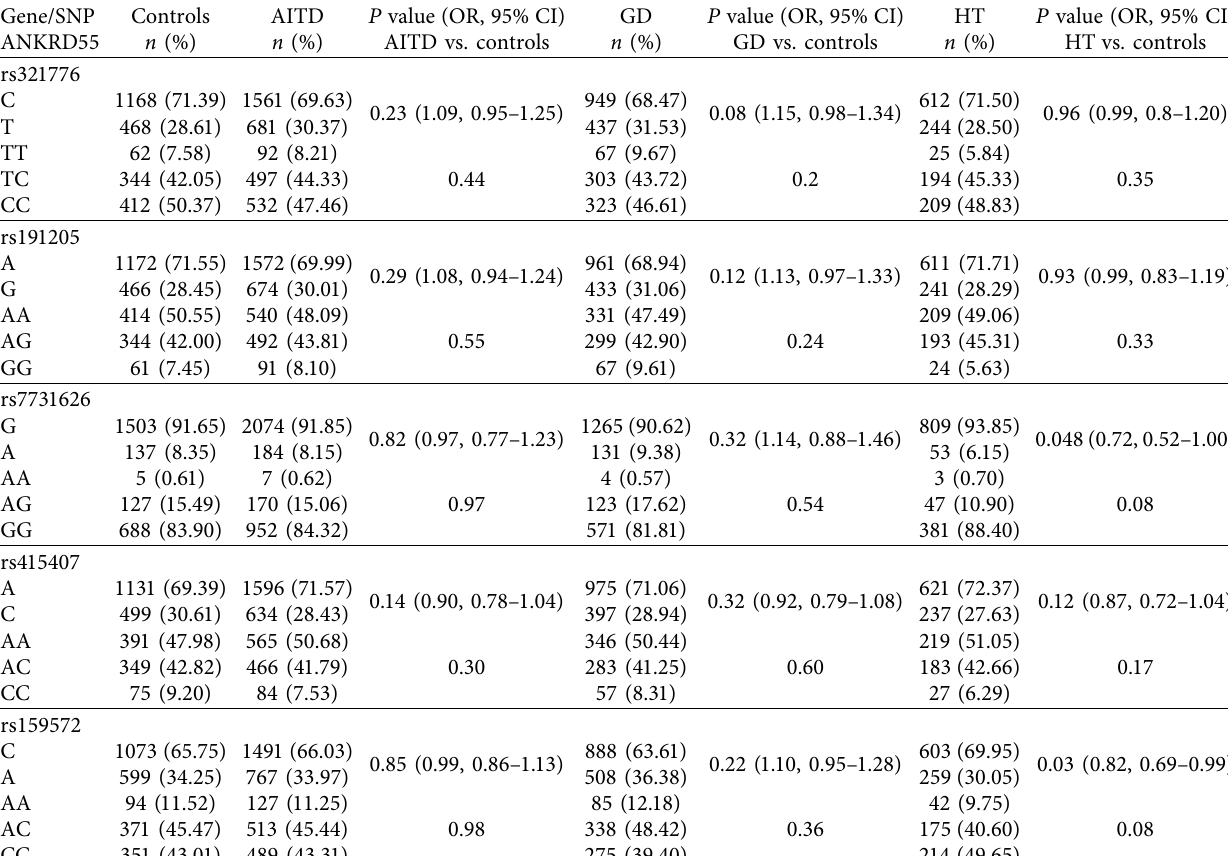
Table 3: Allele and genotype frequencies of the five loci in AITD, GD, HT, and controls.